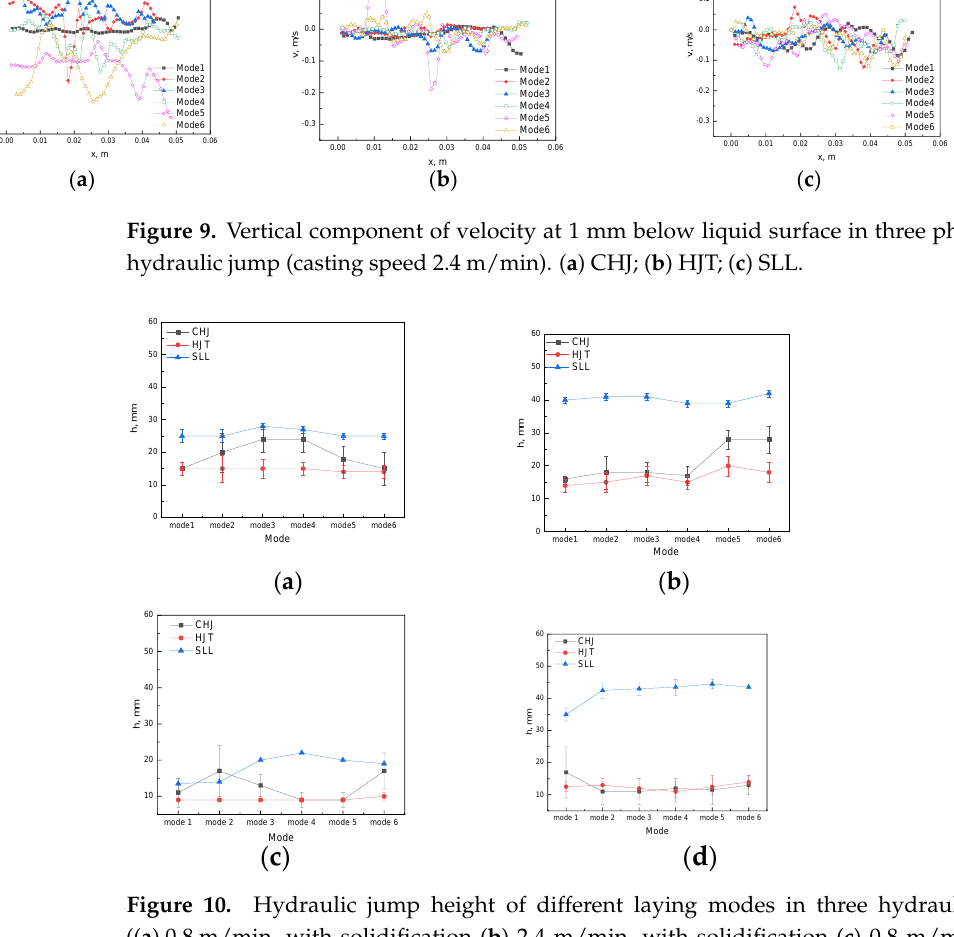
Figure 8. Horizontal component of velocity at 1 mm below liquid surface in three physical forms of hydraulic jump (casting speed 2.4 m/min). ( a ) CHJ; ( b ) HJT; ( c ) SLL.